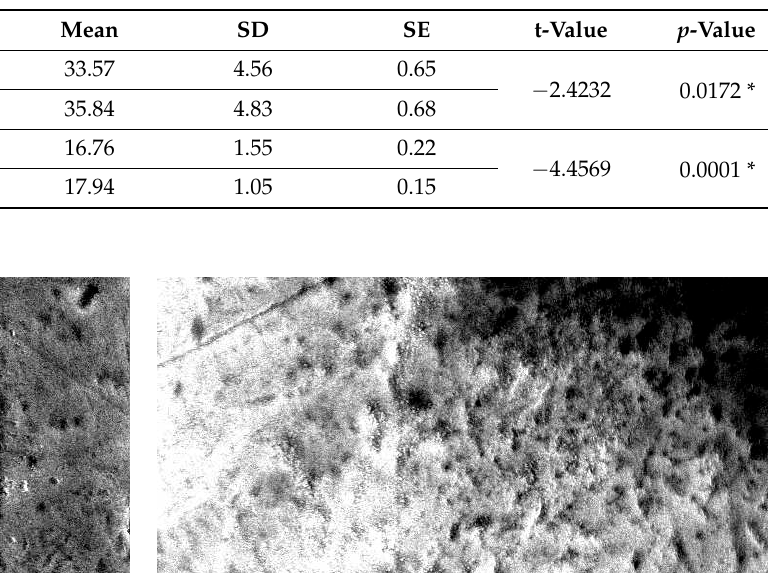
Table 1. Comparison of mean mass percentage of Ca and P between test and control groups.